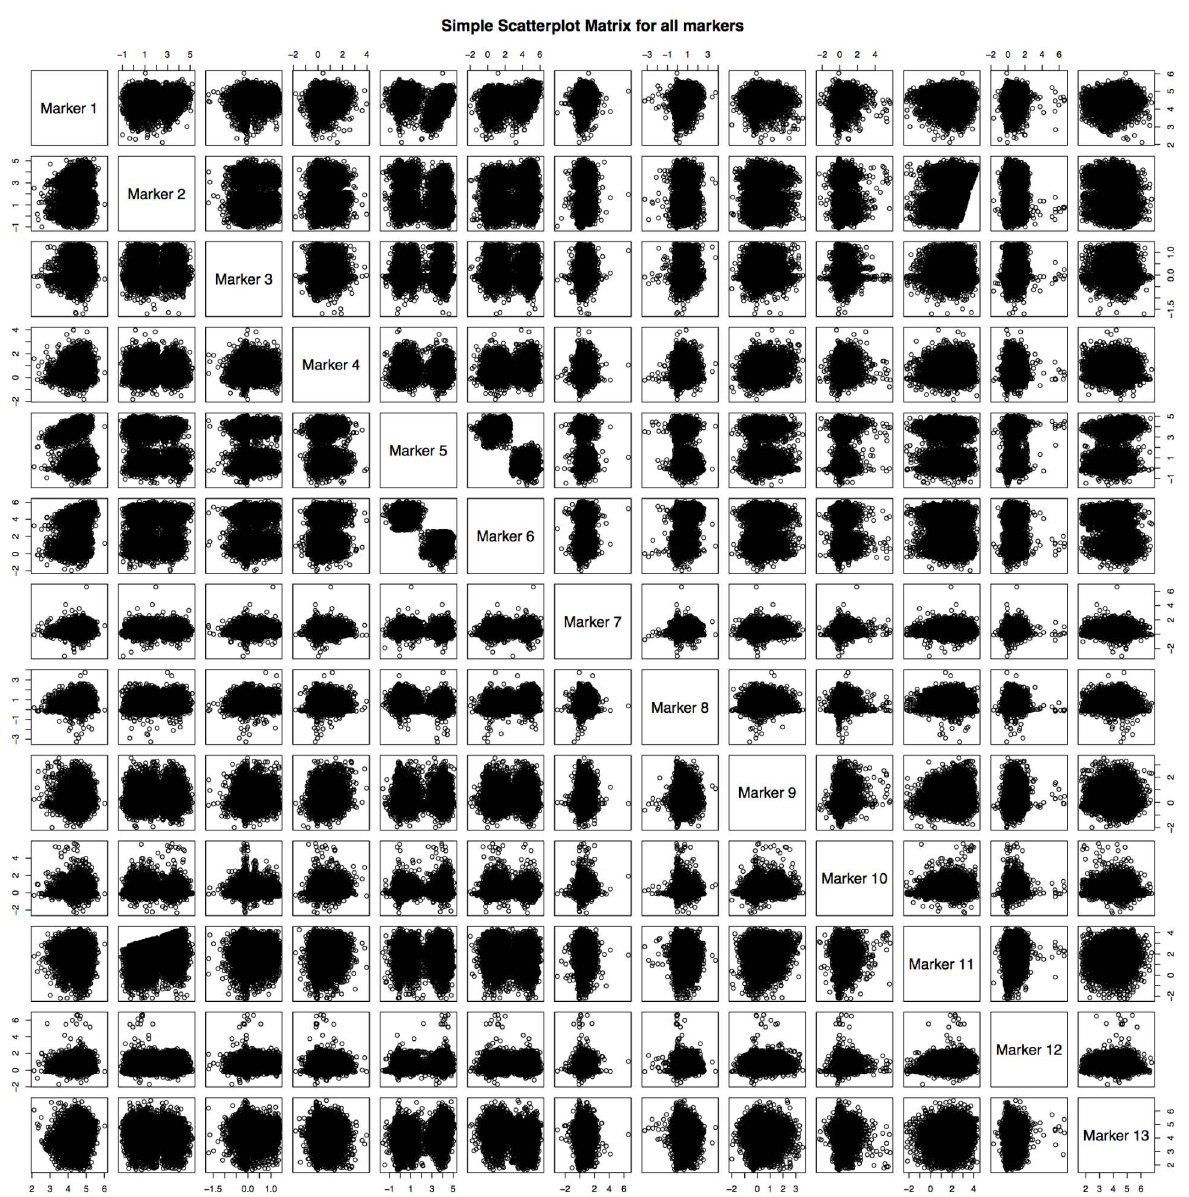
Figure 2. Visualization of 13 markers across heterogeneous population of T-cells. These 13 6 13 scatter plots show pair-wise distribution of 13 markers (unlabeled) per cell from pooled single cell data of 4 T-cell subtypes. Primary data was made publicly available by Bendall et al.